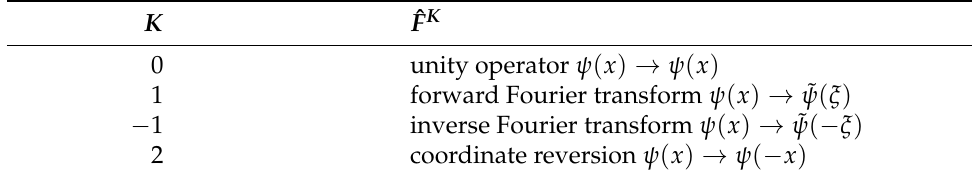
Table 1. Basic directions K π /2 and transforms ˆ F K